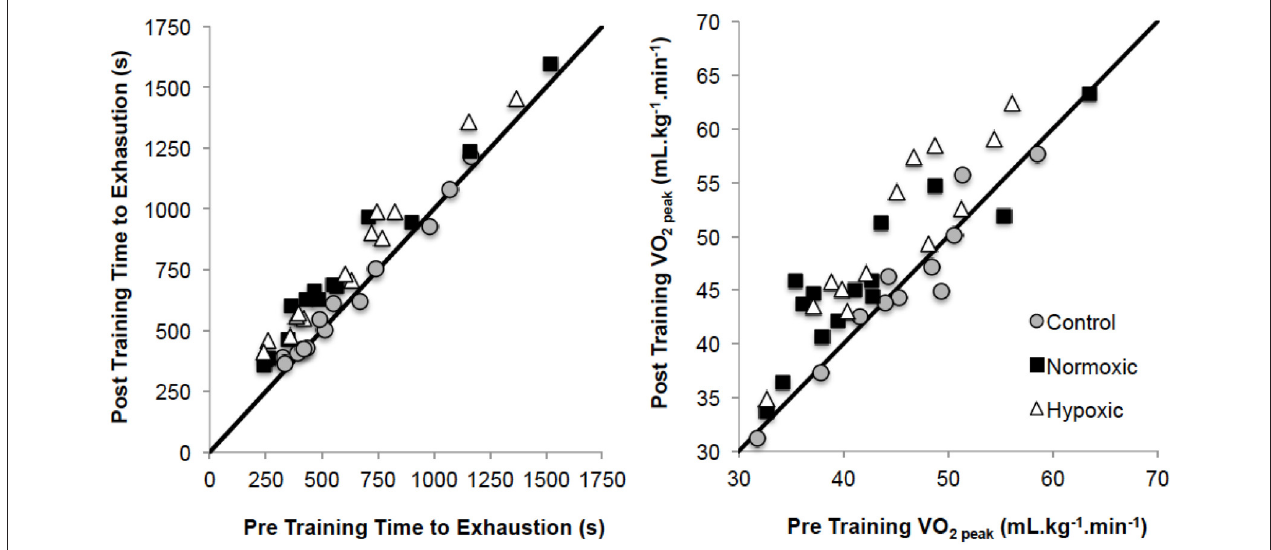
FIGURE 2 | Pre training to post training time to exhaustion and ˙VO 2peak changes for the three training groups. Solid black lines demonstrates the line of equality.